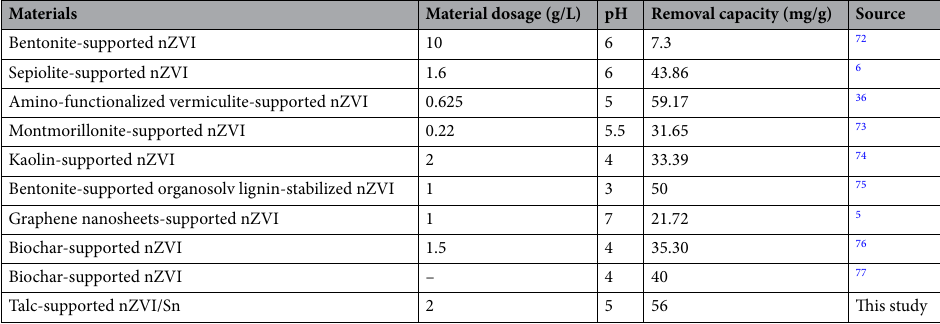
Table 4. It could be found that Talc-nZVI/6Sn provided higher and in some cases similar Cr(VI) removal capac- ity. The high removal capacity (56 mg/g), great longevity, simplicity of synthesis method, and affordable raw